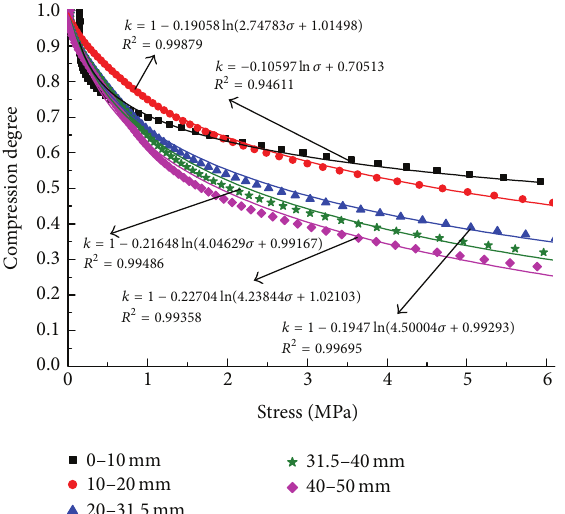
Figure 6: Stress-compression degree for maximum grain size sam-